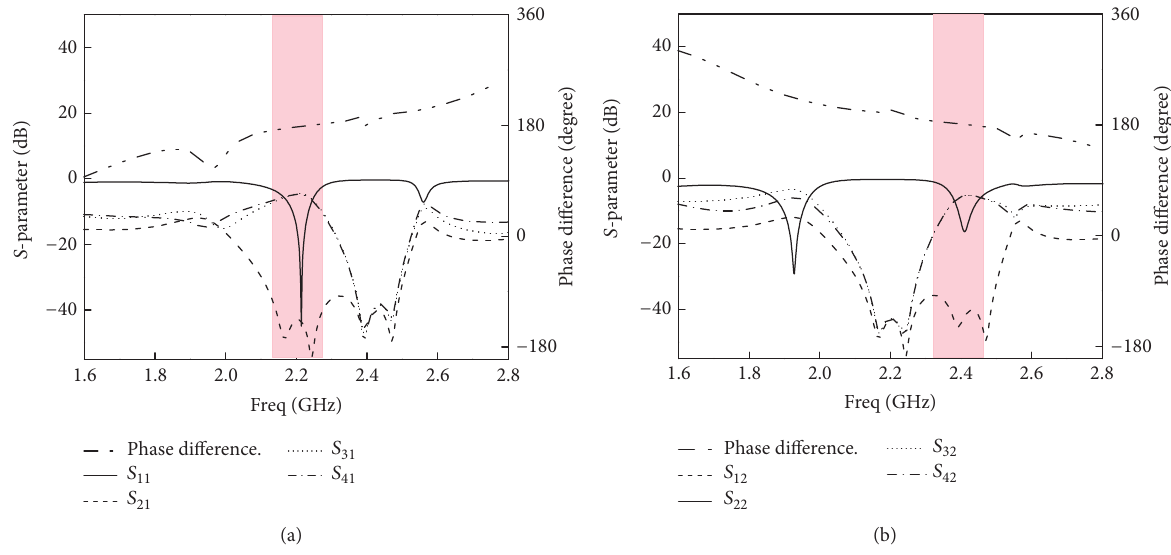
Figure 6: Simulated 𝑆 -parameters and phase differences between the two output ports of the PDDN: (a) port 1 excited; (b) port 2 excited.